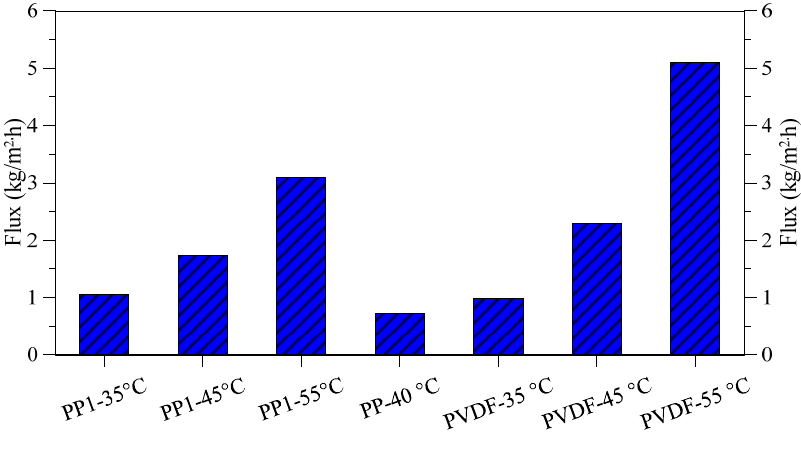
Figure 15. Flux of various membranes tested under different feed inlet